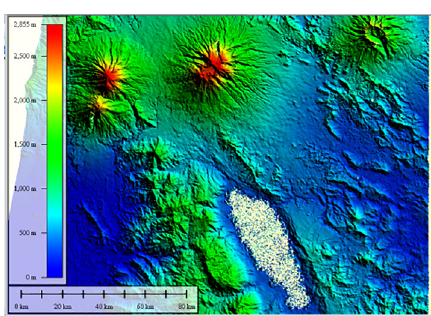
Figure 14. Displacement from